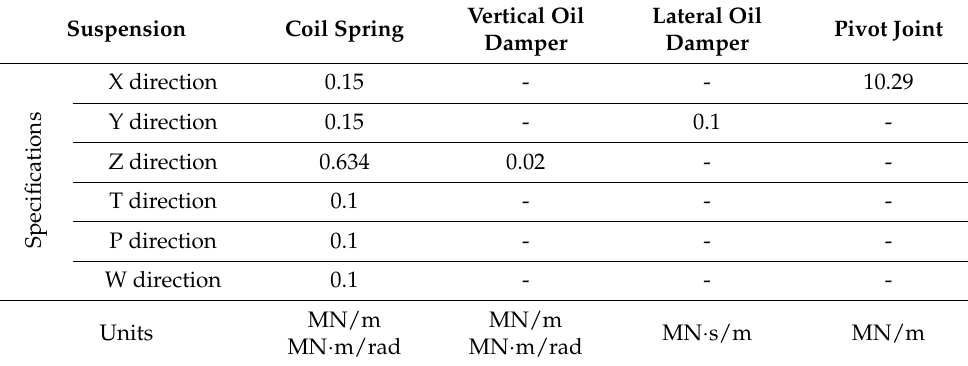
Table 3. Specifications of the secondary suspensions.